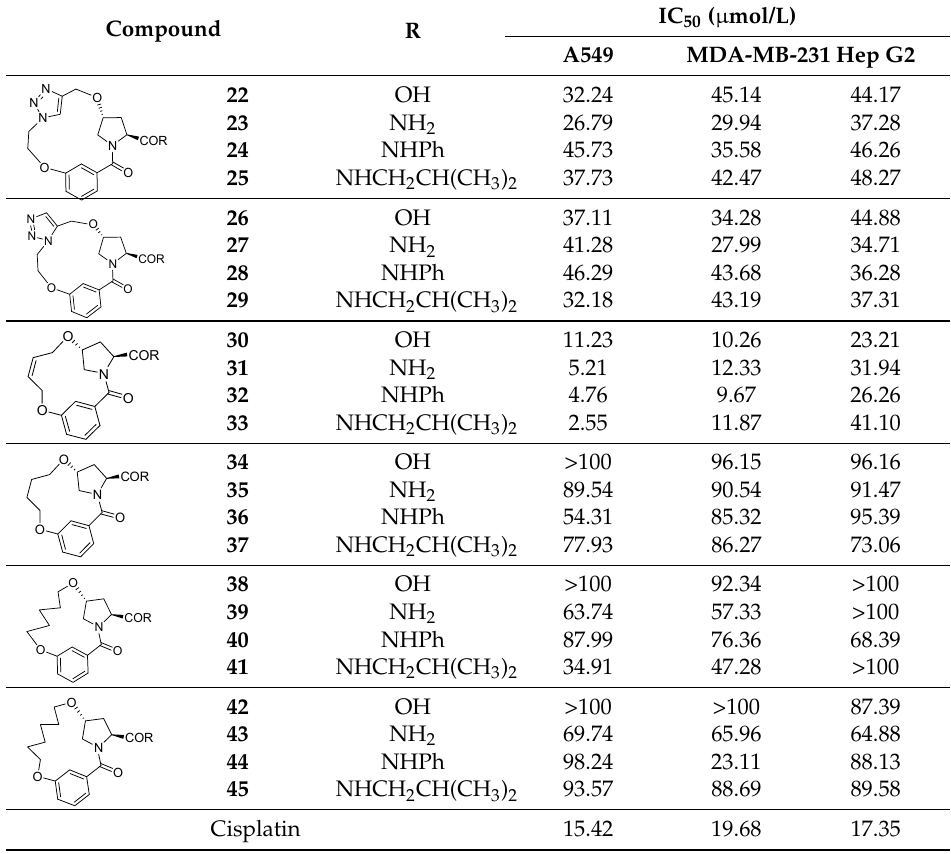
Table 3. Anti-tumor activities of macrocycles. Table 3 Anti-tumor activities of macrocycles. Table 3 Anti-tumor activities of macrocycles. Table 3 Anti-tumor activities of macrocycles. Table 3 Anti-tumor activities of macrocycles. Table 3 Anti-tumor activities of macrocycles. Table 3 Anti-tumor activities of